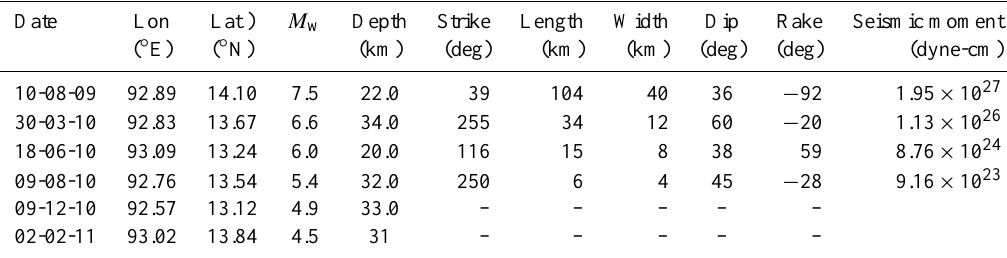
Fig. 3. Top panel gives postseismic stress changes (only viscoelastic) during the period 2005–2008, while the bottom panel gives changes in the combined stress (both viscoelastic and elastic) due to the 26 December 2004 megathrust earthquake. Table 3. Location, magnitude and fault parameters of six Diglipur earthquakes ranging in magnitude from M w = 7.5 to M w = 4.5, which occurred between 10 August 2009 (main event) and 2 February 2011. A dash (–) in the columns of the table implies non-availability of the pertinent